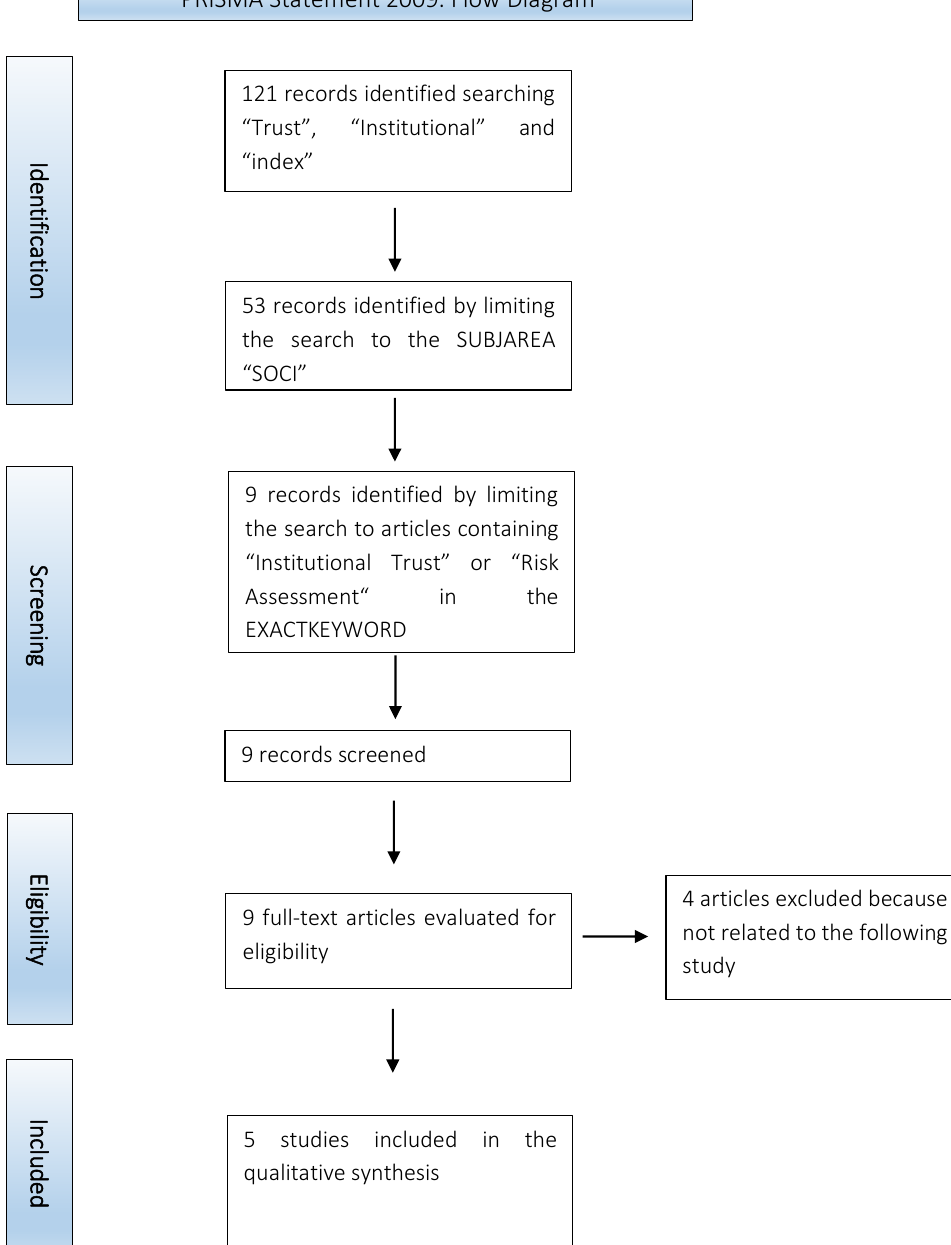
Figure 2. PRISMA statement 2009. Flow diagram: trust in institutions.